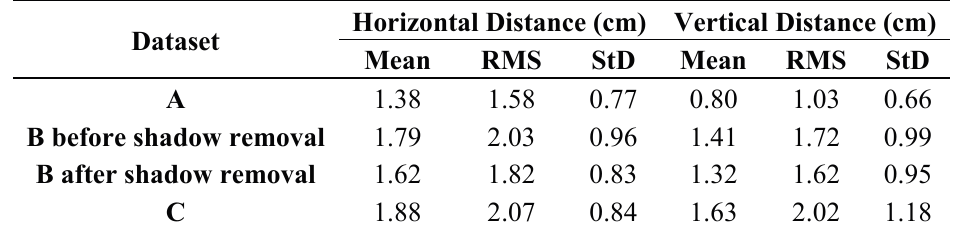
Table 3. Summary of distances between the image-based point clouds and laser-scanner ones.